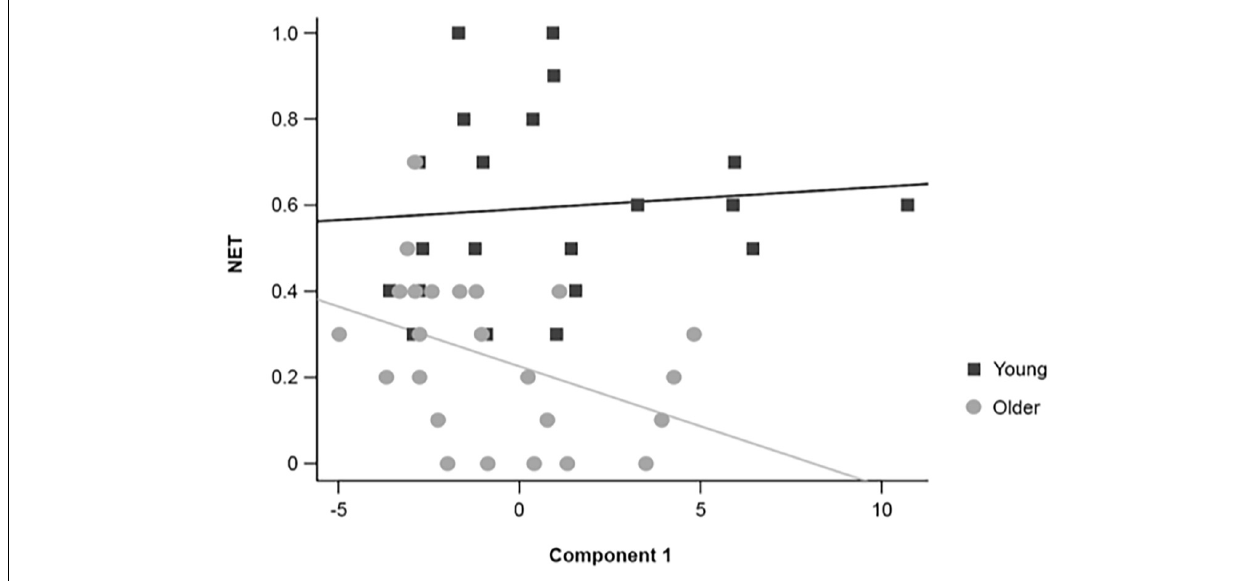
FIGURE 8 | Graphical representation of the individual scores and regression lines between the first EEG component extracted with the PCA and NET for healthy 20–30-year-old (Young; dark gray squares) and 65–75-year-old (Older; light gray circles)